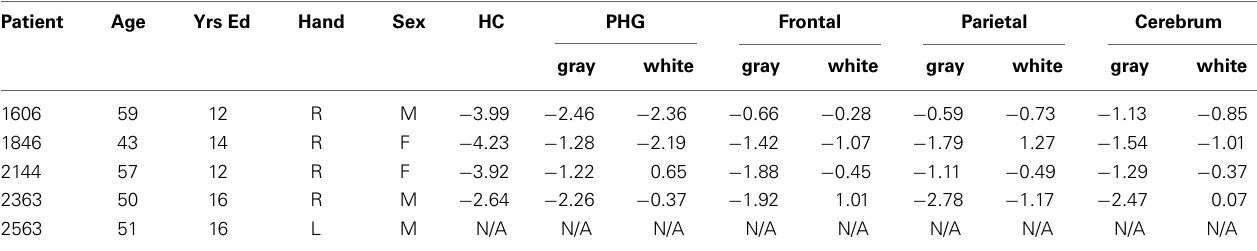
Table 1 | Basic demographic information and brain volumes.